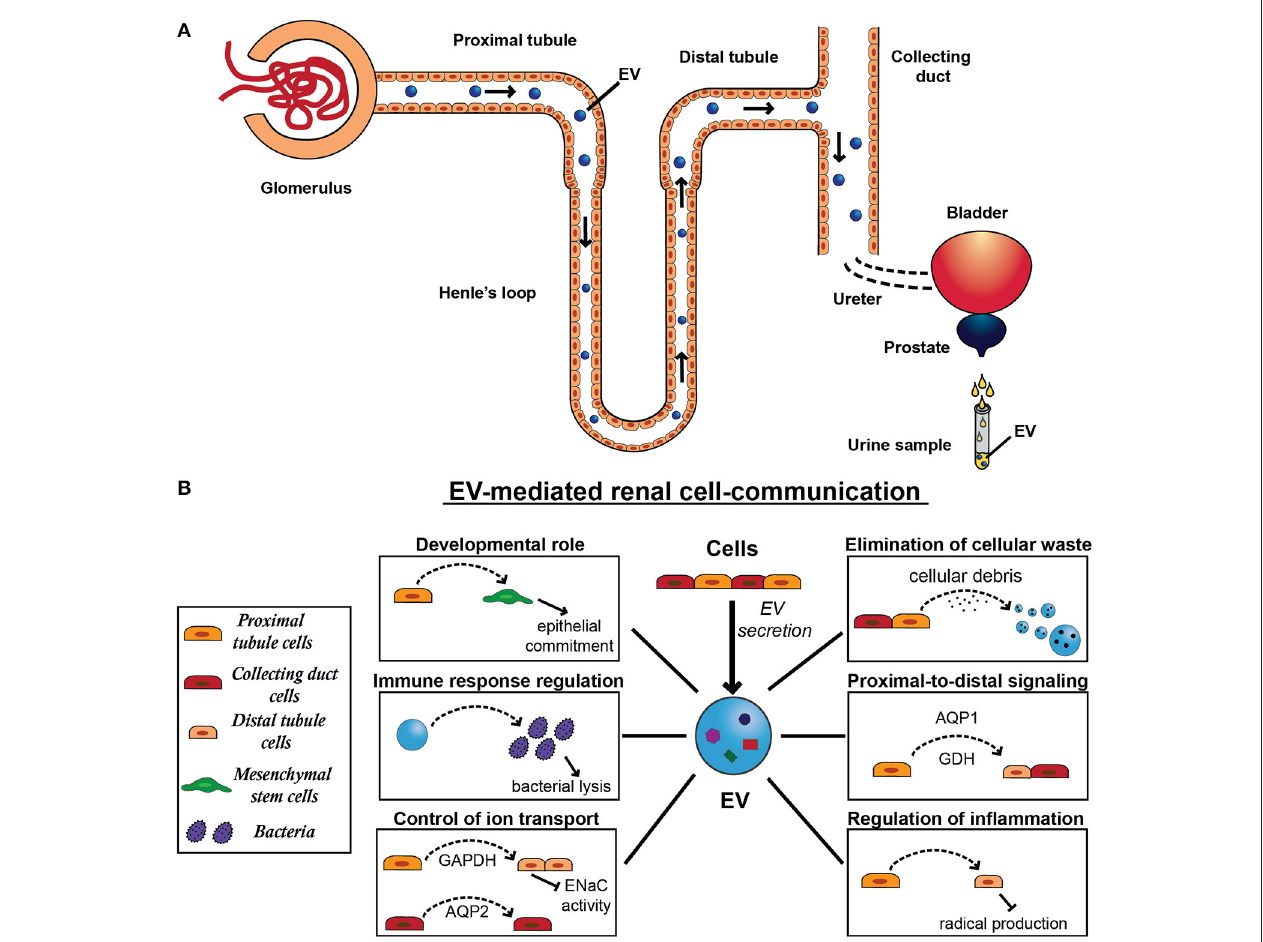
FIGURE 2 | Extracellular vesicle secretion and physiological function in the kidney. (A) All cell types of the nephron that face the urinary space secrete EVs, starting from the glomerular podocytes through the proximal tubule, the limb of Henle, the distal tubule, and the collecting duct. After their secretion, EVs can be uptaken by downstream cells, influencing recipient cell behavior. Alternatively to their action on cells, EVs can cross the urinary tract and pass through following organs, including ureters, bladder, prostate, and urethra. EVs released by resident epithelial cells congregate with renal EVs and ultimately conveyed in the urine, providing a source of physiopathological markers of the urinary tract. (B) EV-mediated renal communication seems to be a physiological system of cell signaling and involves several EV roles, including elimination of cellular waste, proximal-to-distal signaling, developmental roles, control of ion transport, regulation of inflammation and immune response. In fact, EVs released by proximal tubule cells can be uptaken by distal tubule and collecting duct cells transferring tubular proteins, such as aquaporin-1 (AQP1) and the ammonium-generating enzyme glutaminase (GDH). EVs can also mediate the transfer of another aquaporin member, aquaporin-2 (AQP2) between cortical collecting duct cells. Moreover, by carrying active GAPDH, proximal tubule cells can regulate the renal transport of sodium through EVs, decreasing ENaC activity in distal tubule and collecting duct cells. Similarly, these EVs can also transfer anti-inflammatory message from proximal tubular cells exposed to dopamine receptor agonist and induce a decrease in cell radical production in distal tubular cells. Moreover, EVs derived from tubular cells are implicated in an important process for nephrogenesis and mediate the induction of the mesenchymal-to-epithelial transition (MET) in mesenchymal stem cells (MSCs). Finally, urinary EVs can